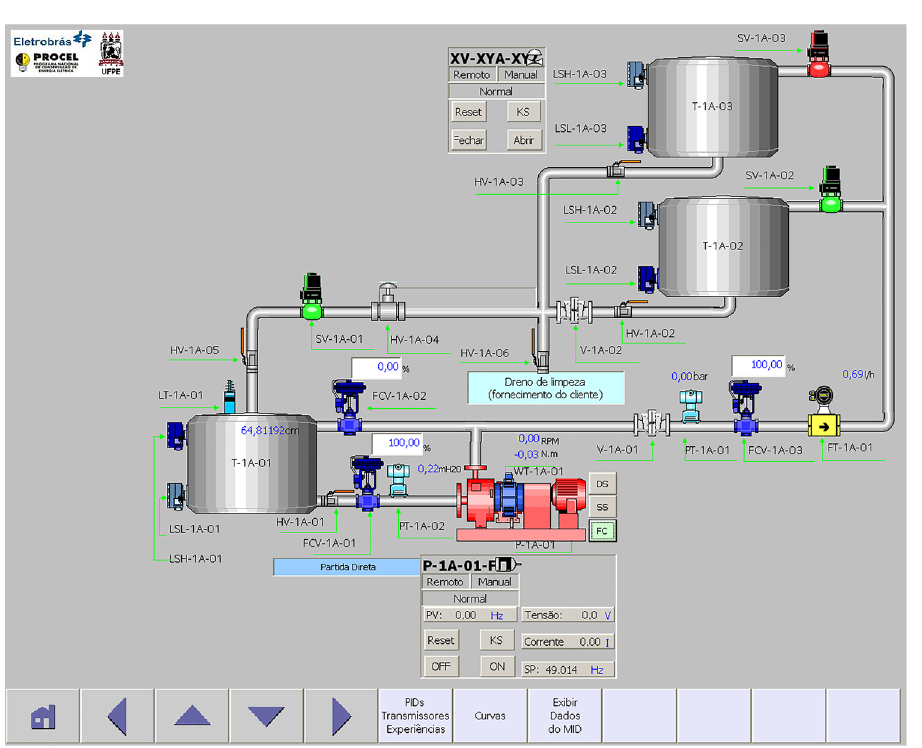
Figure 14. LEEQE pump bench preview screen in